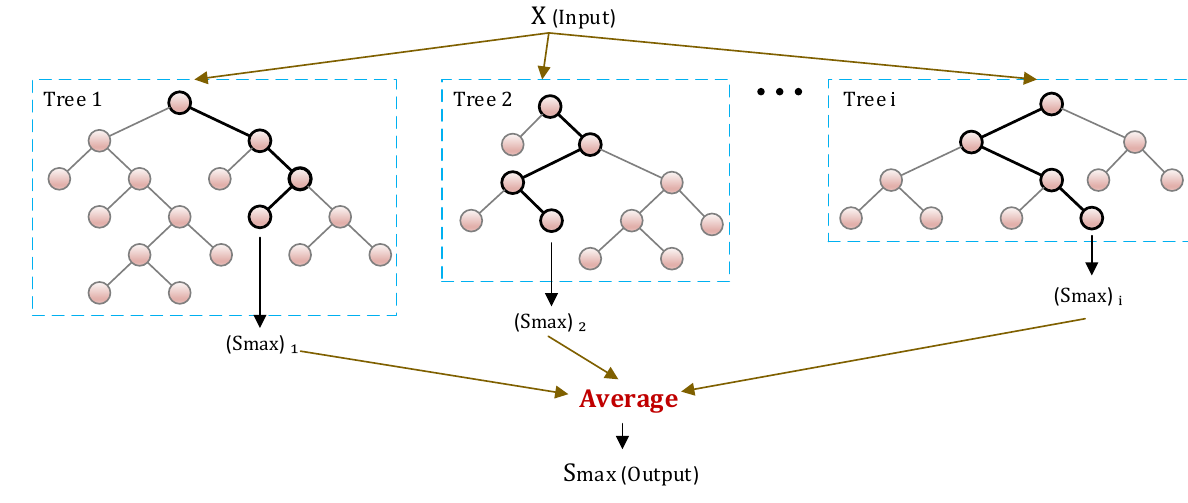
Figure 1. A general architecture of an RF for prediction.